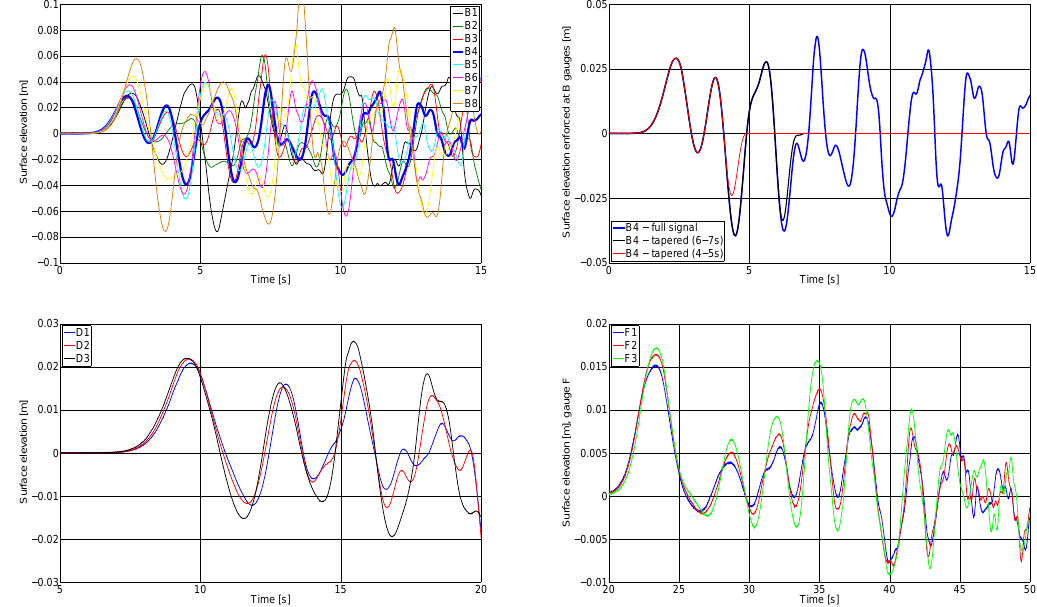
Figure 3. Upper left panel: measured surface elevations for the all the wave gauges at the B-bridge. Upper right panel: the tapered B4 sig- nals that were used to provide input to the Coulwave simulations compared to the non-tapered signal. Lower left panel: measured surface elevations for all the wave gauges at the D-bridge. Lower right panel: Measured surface elevations for all the wave gauges at the F-bridge. All measurement data are taken from Lindstrøm et al.